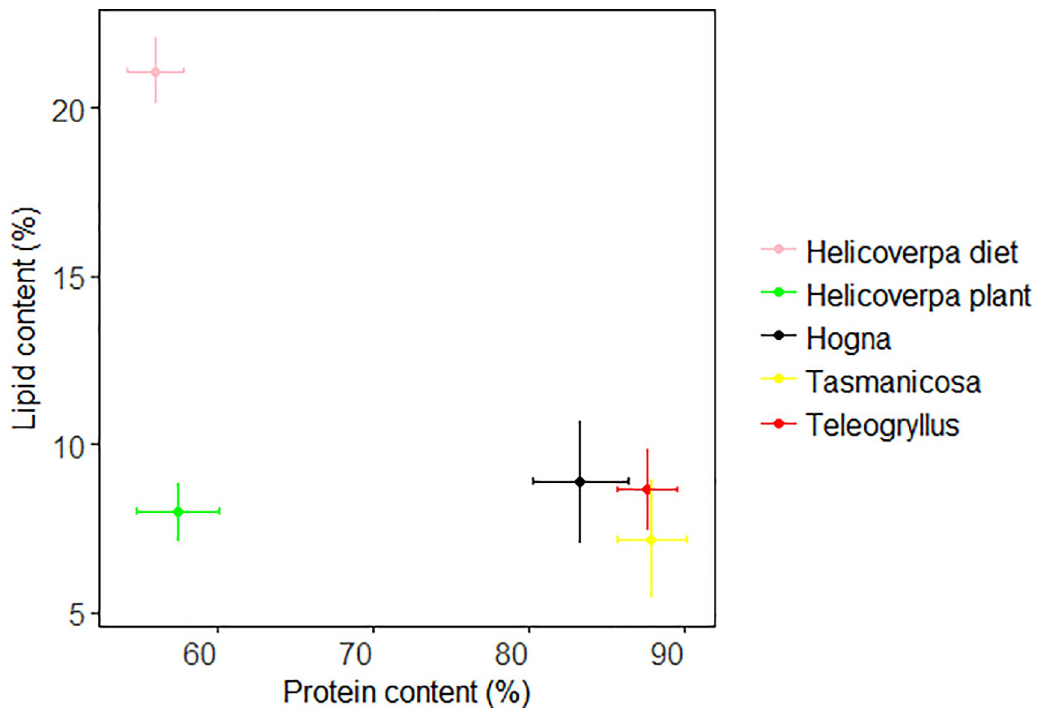
Fig 3. Percent body content of protein and lipid in four arthropods (mean and SD), caught near cotton fields, reared on cotton plant material, or reared on soy and agar diet.